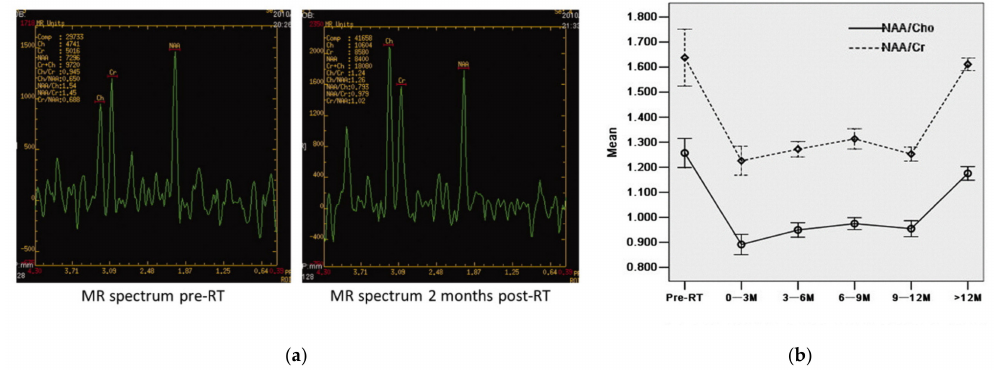
Figure 5. ( a ) Metabolic changes before and two months after radiotherapy. The MRS evaluation results in a decrease of NAA/Cho and NAA/Cr two months post-RT. ( b ) The curves show the alterations of NAA/Cr and NAA/Cho over time for the whole cohort. Reprinted from Xiong et al. [71] with permission from